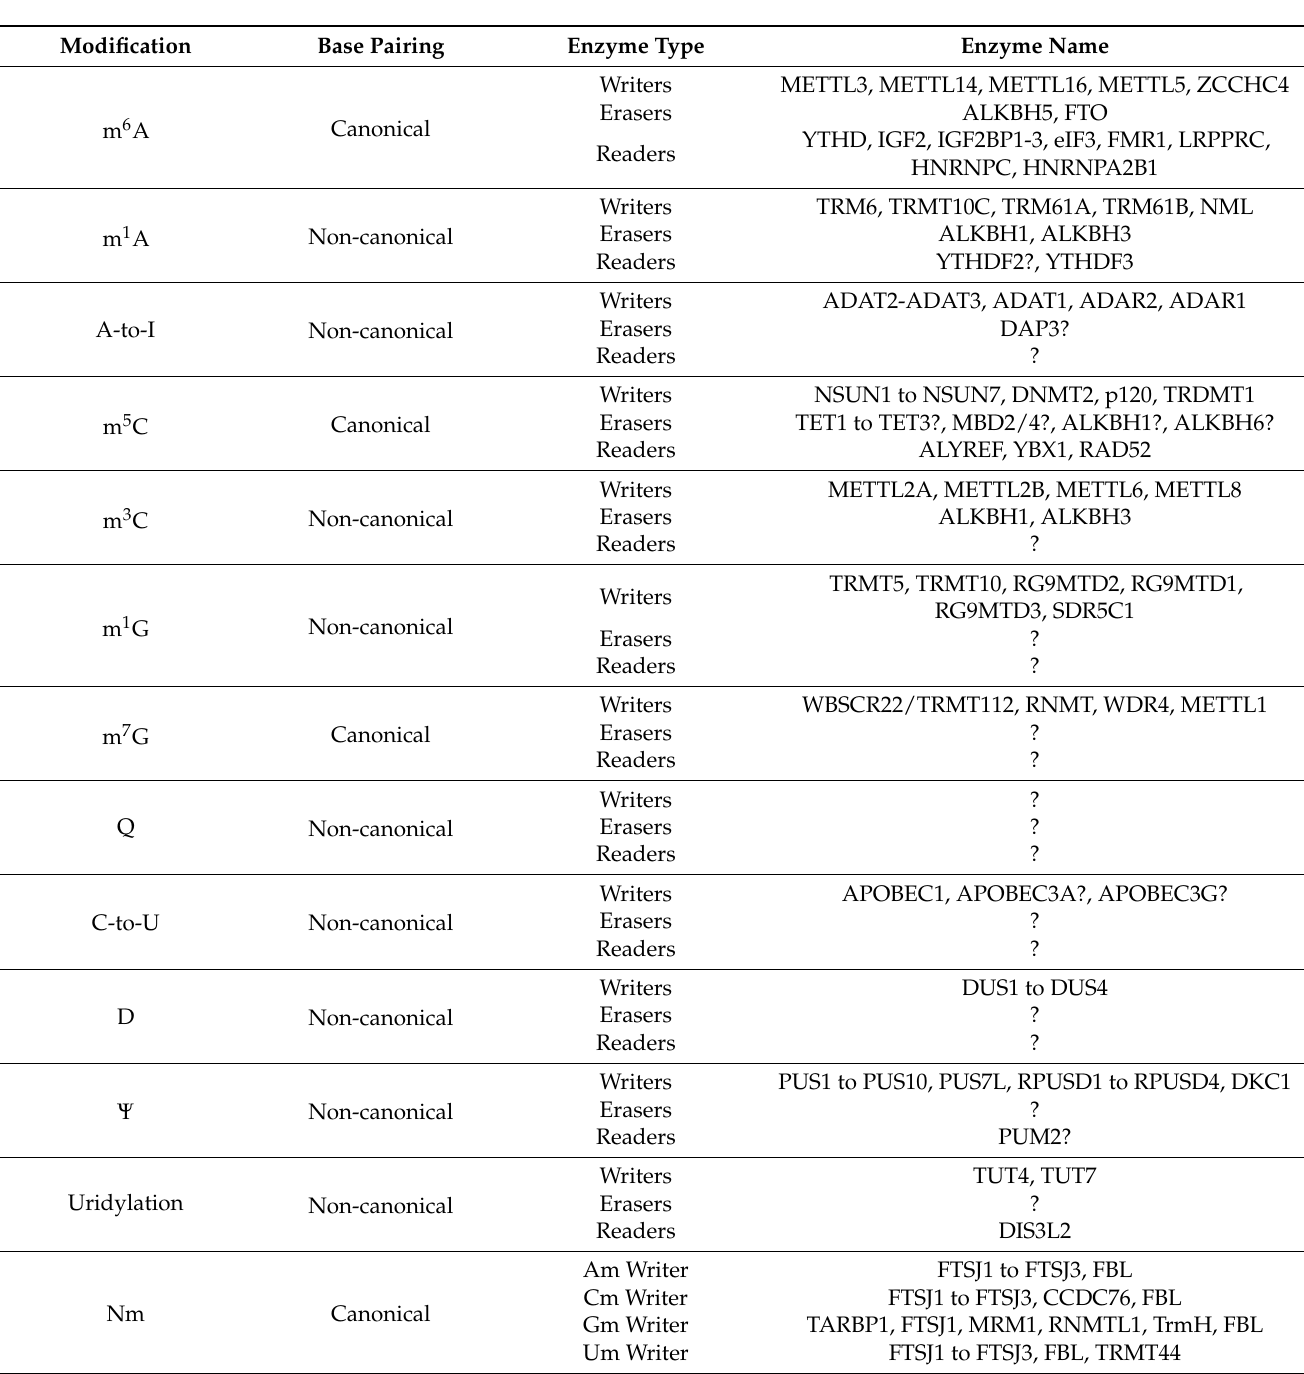
Table 1. Enzymes catalyzing the addition, removal and recognition of common RNA modifications in human